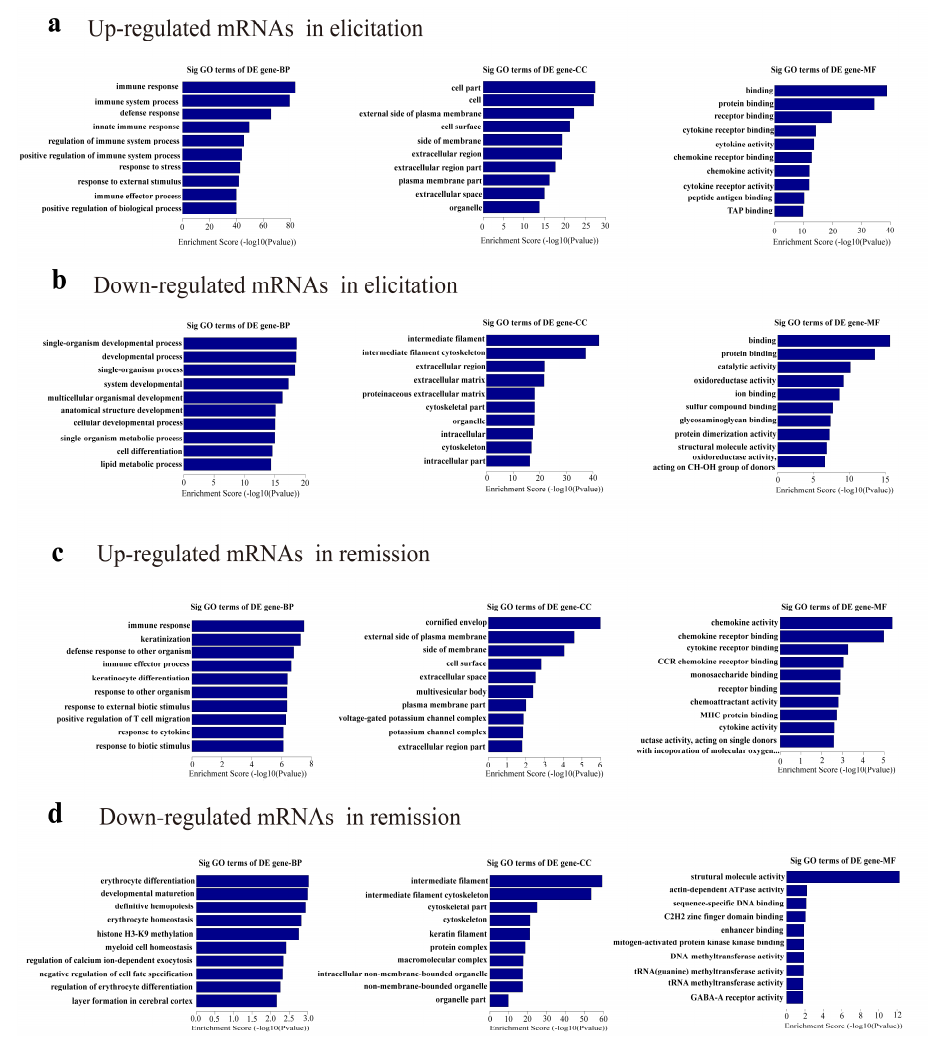
Figure 3. Gene ontology (GO) analysis. ( a – d ) GO annotation of upregulated and downregulated mRNAs in elicitation and remission phase of AD recurrence model, with the top ten enrichment scores covering domains of biological processes (BP), cellular components (CC), and molecular functions